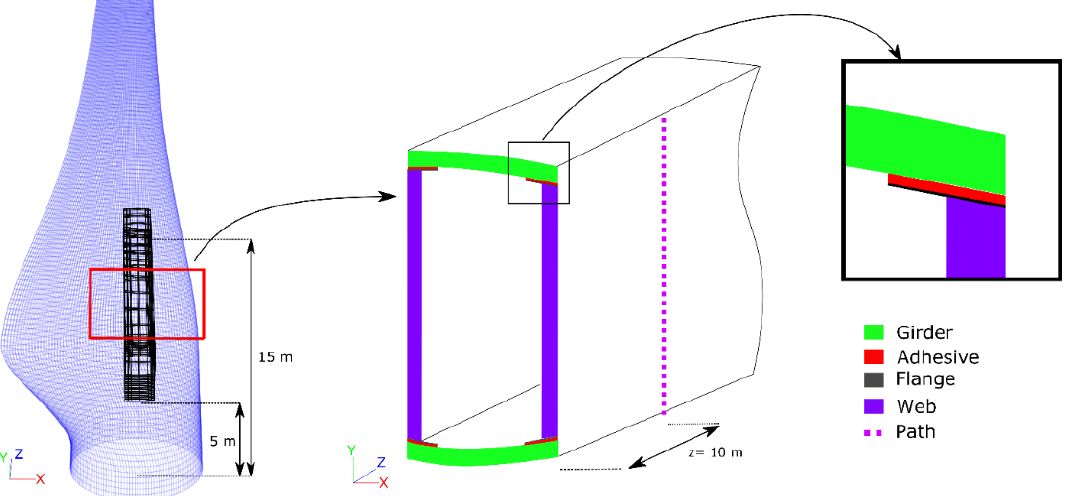
Figure 3. In a first approach, the model was limited to a portion of the spar; ( left ) spar segment in the overall blade; ( middle ) front view of the spar, showing the unidirectional (UD) girders, shear webs with flanges, and adhesive bonds. A path for the extraction of data from the simulations was added to the side of the model over the full height of the spar; ( right ) close-up view of a corner of the spar segment. Table 1. Overview of the considered load cases for the spar segment.